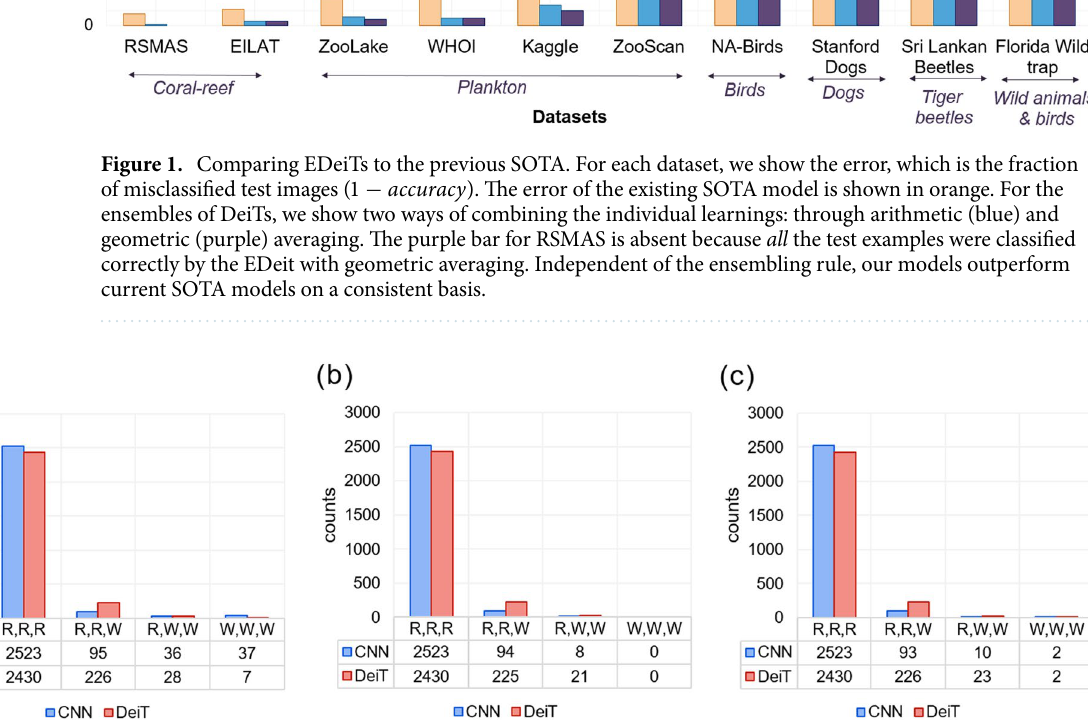
Figure 2. Comparison between three-model ensemble models based on CNNs and on DeiTs on the ZooLake test set. The bar heights indicate how often each combination (RRR, RRW, RWW, WWW) appeared. RRR indicates that all the models gave the right answer, RRW means that one model gave a wrong answer, and so on. The numbers below each bar indicate explicitly the height of the bar. On panel ( a ) we consider the whole test set, on panel ( b ) we only consider the examples which were correctly classified by the arithmetic ensemble average, and on panel ( c ) those correctly classified through geometric ensemble